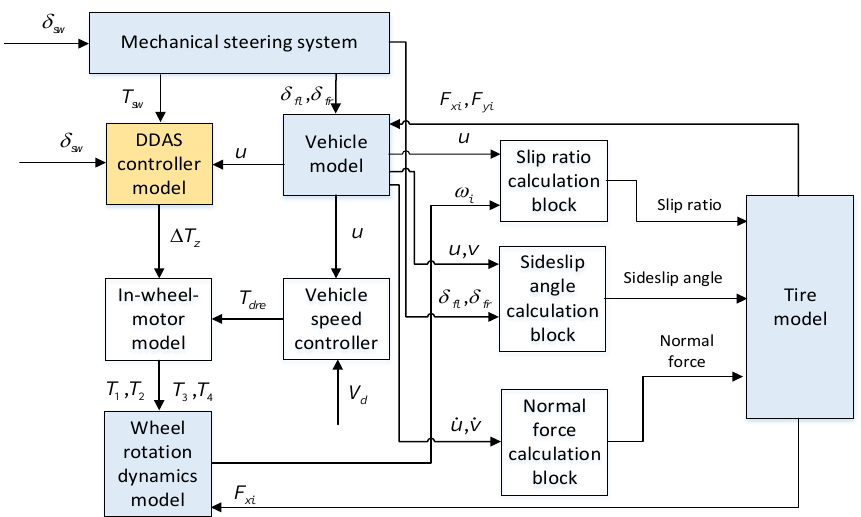
Figure 3. The whole block diagram of independent-wheel-drive electric vehicle model.